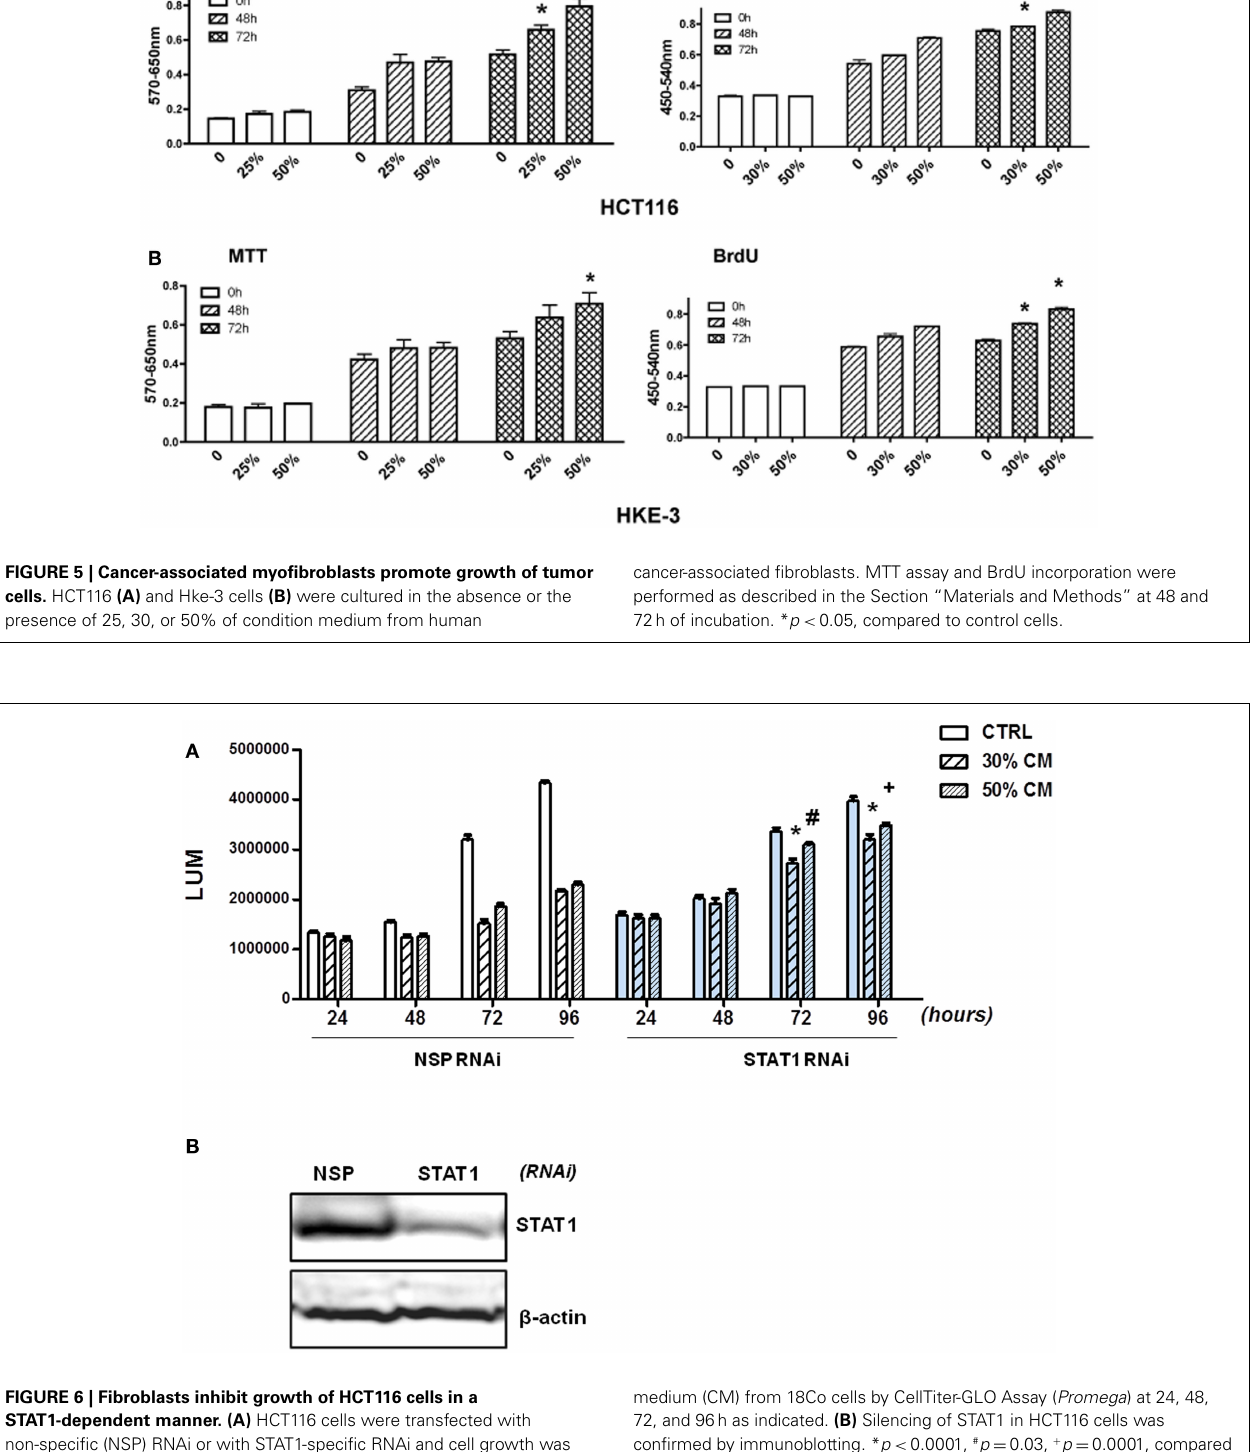
FIGURE 6 | Fibroblasts inhibit growth of HCT116 cells in a STAT1-dependent manner. (A) HCT116 cells were transfected with non-specific (NSP) RNAi or with STAT1-specific RNAi and cell growth was monitored in the absence (CTRL) or the presence of 30% or 50% conditioned